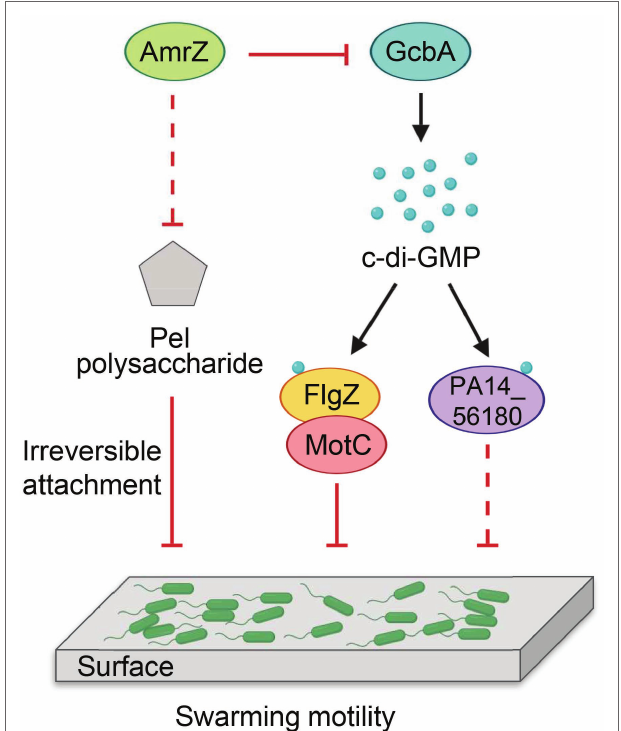
FIGURE 8 | Model for AmrZ-mediated swarming motility control. AmrZ affects swarming by negatively regulating the production of Pel polysaccharide and a GcbA-dependent c-di-GMP signaling. The Pel polysaccharide inhibits swarming motility by promoting the transition from reversible to irreversible attachment (Caiazza et al., 2007). The GcbA c-di-GMP signal can be further sensed by two PilZ-containing proteins, FlgZ and PA14_56180. Binding of c-di-GMP to FlgZ induces its interaction with the MotC stator and impairs flagellar function probably by preventing the engagement of MotCD with the rotor (Baker et al., 2016). PA14_56180 regulates swarming in a c-di-GMP-dependent manner, but the downstream target(s) of PA14_56180 remains unknown. The solid lines represent direct regulations, and the dashed lines indicate probable indirect